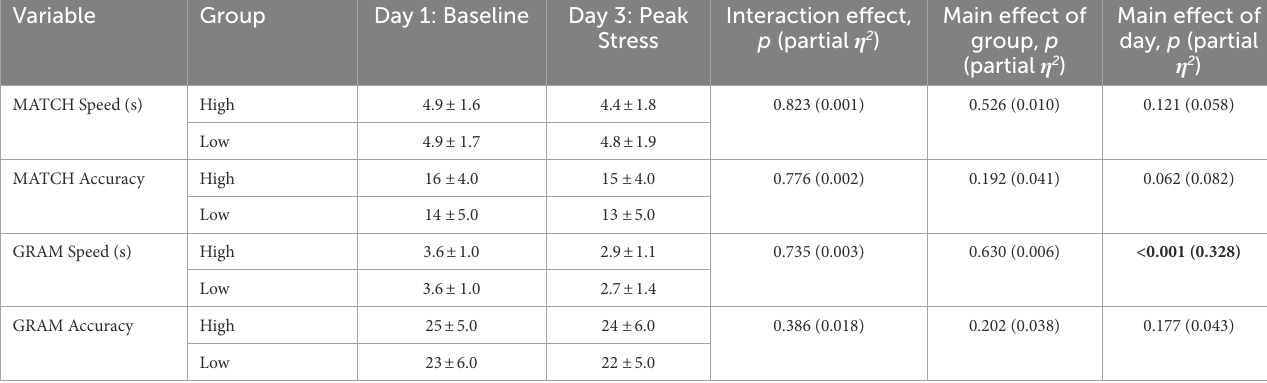
TABLE 4 Neurocognitive test batteries stratified by low and high adaptivity at baseline and peak stress. Variable